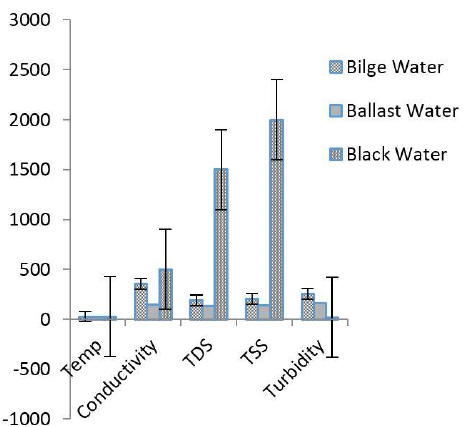
Figure 2. Distribution of the physical parameters of shipborne wastewater.